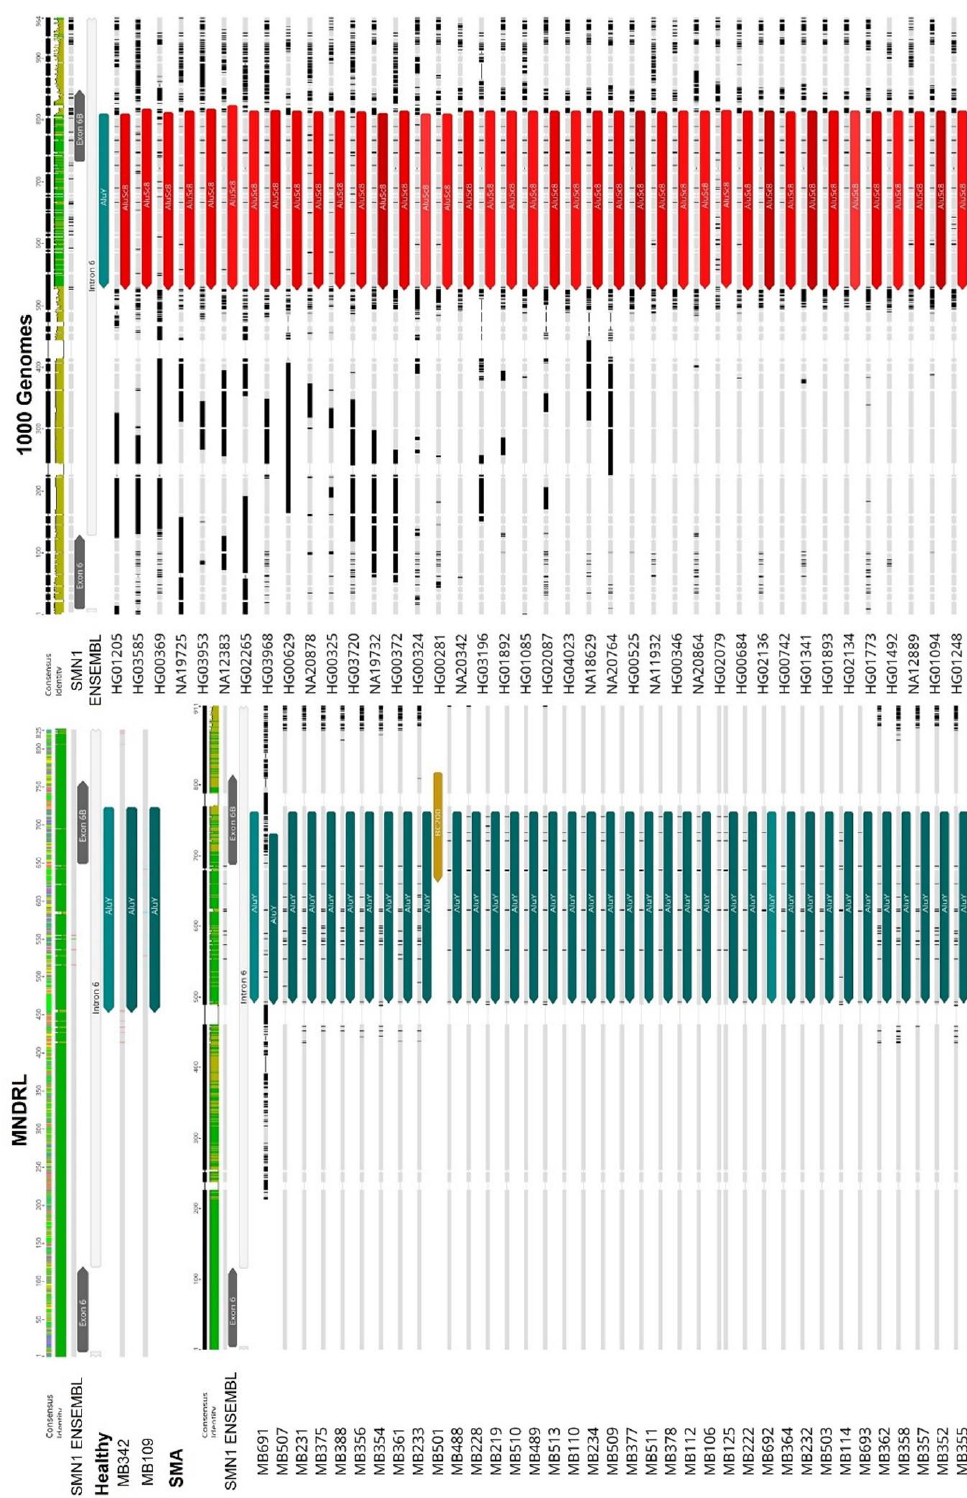
Figure 9. Comparison of the exon 6B region within the sample cohort. An AluY insertion (represented by a teal arrow) gives rise to alternative exon 6B in all healthy and SMA samples, including the reference SMN1 ENSEMBL sequence. Contrarily, an AluSc8 (represented by a red arrow) insertion is present instead of the AluY element in the remaining samples. This Alu insertion difference is most likely the result of low sequencing read depth of the 1000 Genomes Project samples.